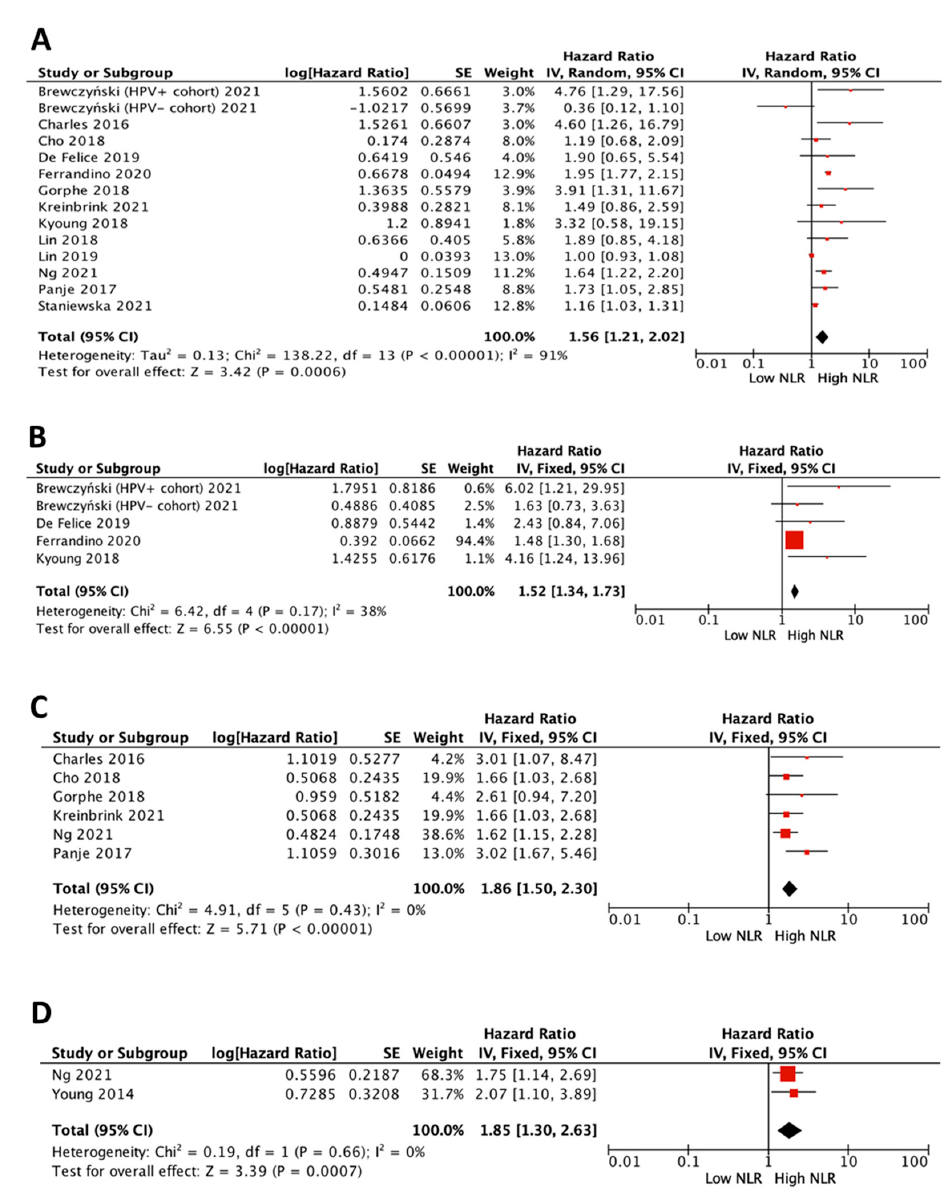
Figure 2. Forest plots of impact of NLR in “all patients” on overall survival ( A ), disease-free survival ( B ), recurrence-free survival ( C ) and locoregional control ( D ). [13-26].